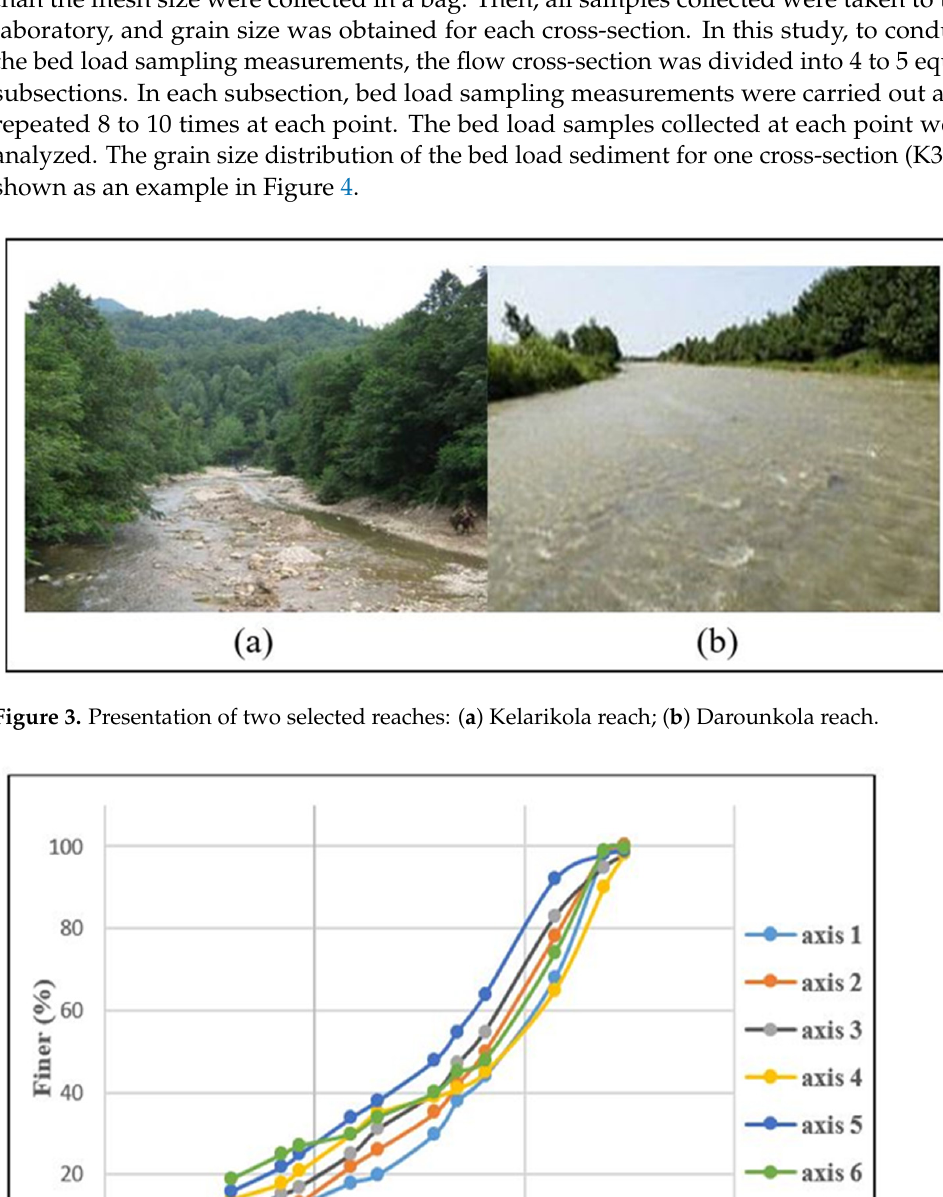
load sediment. This sampler was placed on the channel bed. After a period of 60 s, parti-